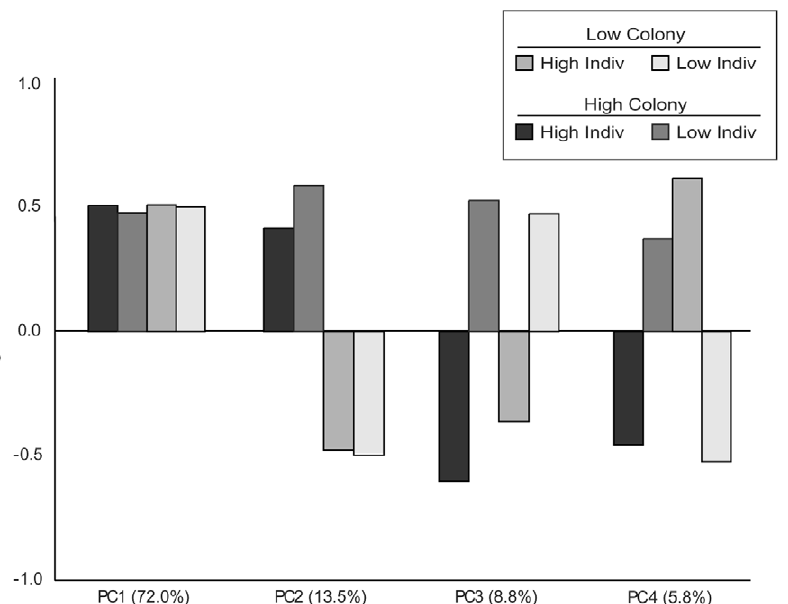
Figure 3. Brain gene expression patterns associated with individual and colony-level differences. Principal component analysis indicates that the primary variance in the dataset is associated with variation in expression among genes, and accounts for 72% of the observed variance (Figure 3, PC1). Furthermore, a large proportion of the variance in transcript abundance is associated with colony-level behavioral differences (PC2, 13.5%) and differences in individual pheromone response (PC3, 8.8%). The final principal component appears to be associated with the interaction between individual and colony-level behaviors, and represents 5.5% of the observed transcriptional variation.